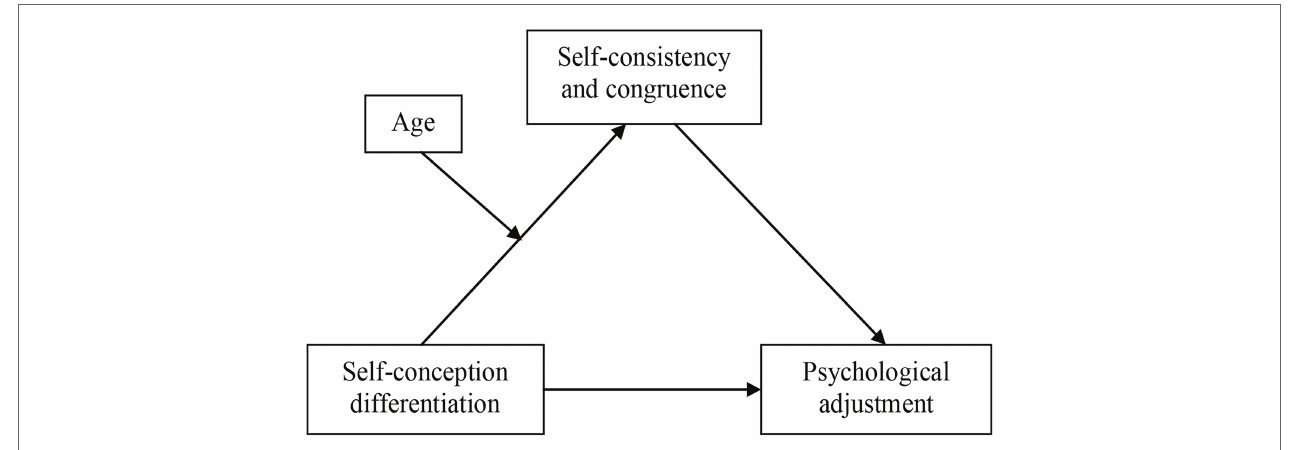
FIGURE 1 | Theoretical models of moderated mediation effect linking self-concept differentiation and psychological